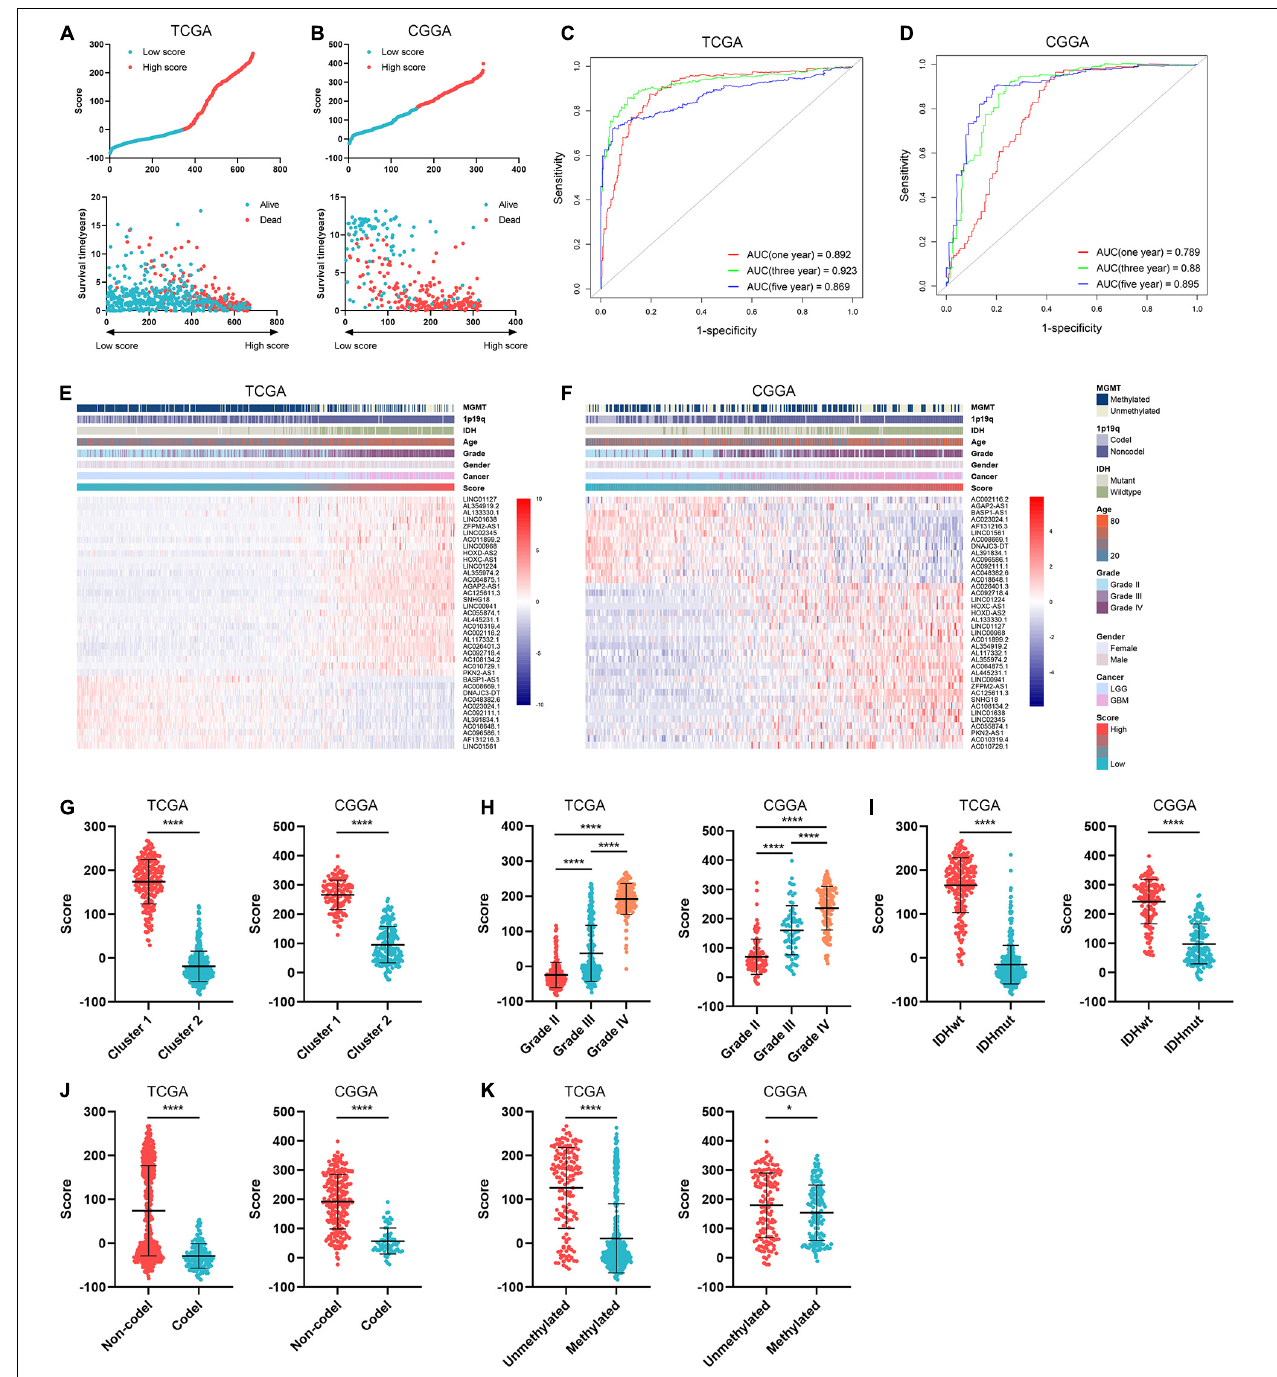
FIGURE 5 | ARL signature correlated with prognosis and clinical features of gliomas. (A,B) ARL score was calculated in diffuse glioma samples in TCGA (A) and CGGA (B) datasets. (C,D) Time-dependent ROC analysis of ARL score in predicting the survival of glioma patients in TCGA (C) and CGGA (D) datasets. (E,F) The expression of 38 ARLs in low-score and high-score samples in TCGA (E) and CGGA (F) datasets. (G) ARL score in two clusters in TCGA and CGGA datasets. (H–K) ARL score in different grades (H) , IDH1 status (I) , MGMT status (J) , and 1p19q status (K) of gliomas in in TCGA and CGGA datasets. ∗ p < 0.05; ∗∗∗∗ p <